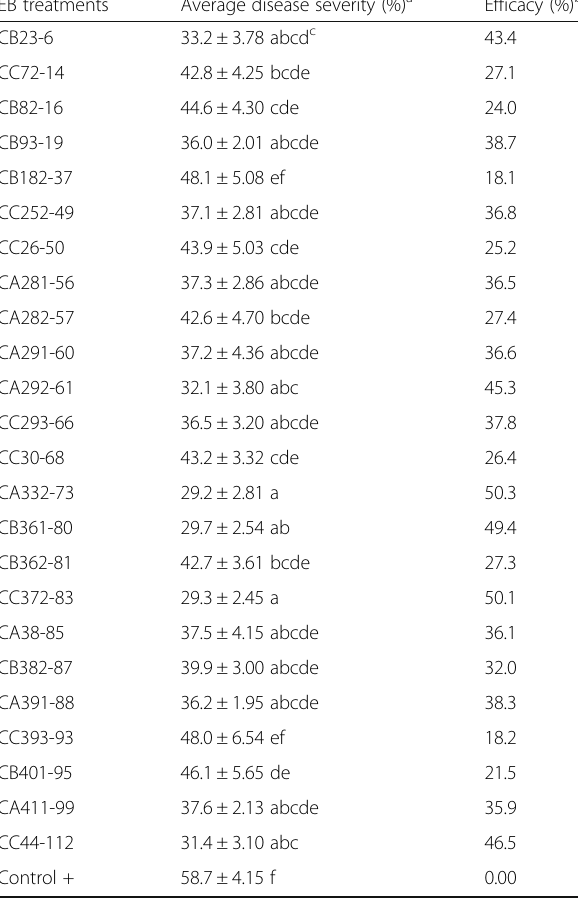
Table 3 Effects of endophytic bacteria treatments on Pseudomonas syringae pv. lachrymans disease severity in cucumber plants under growth chamber